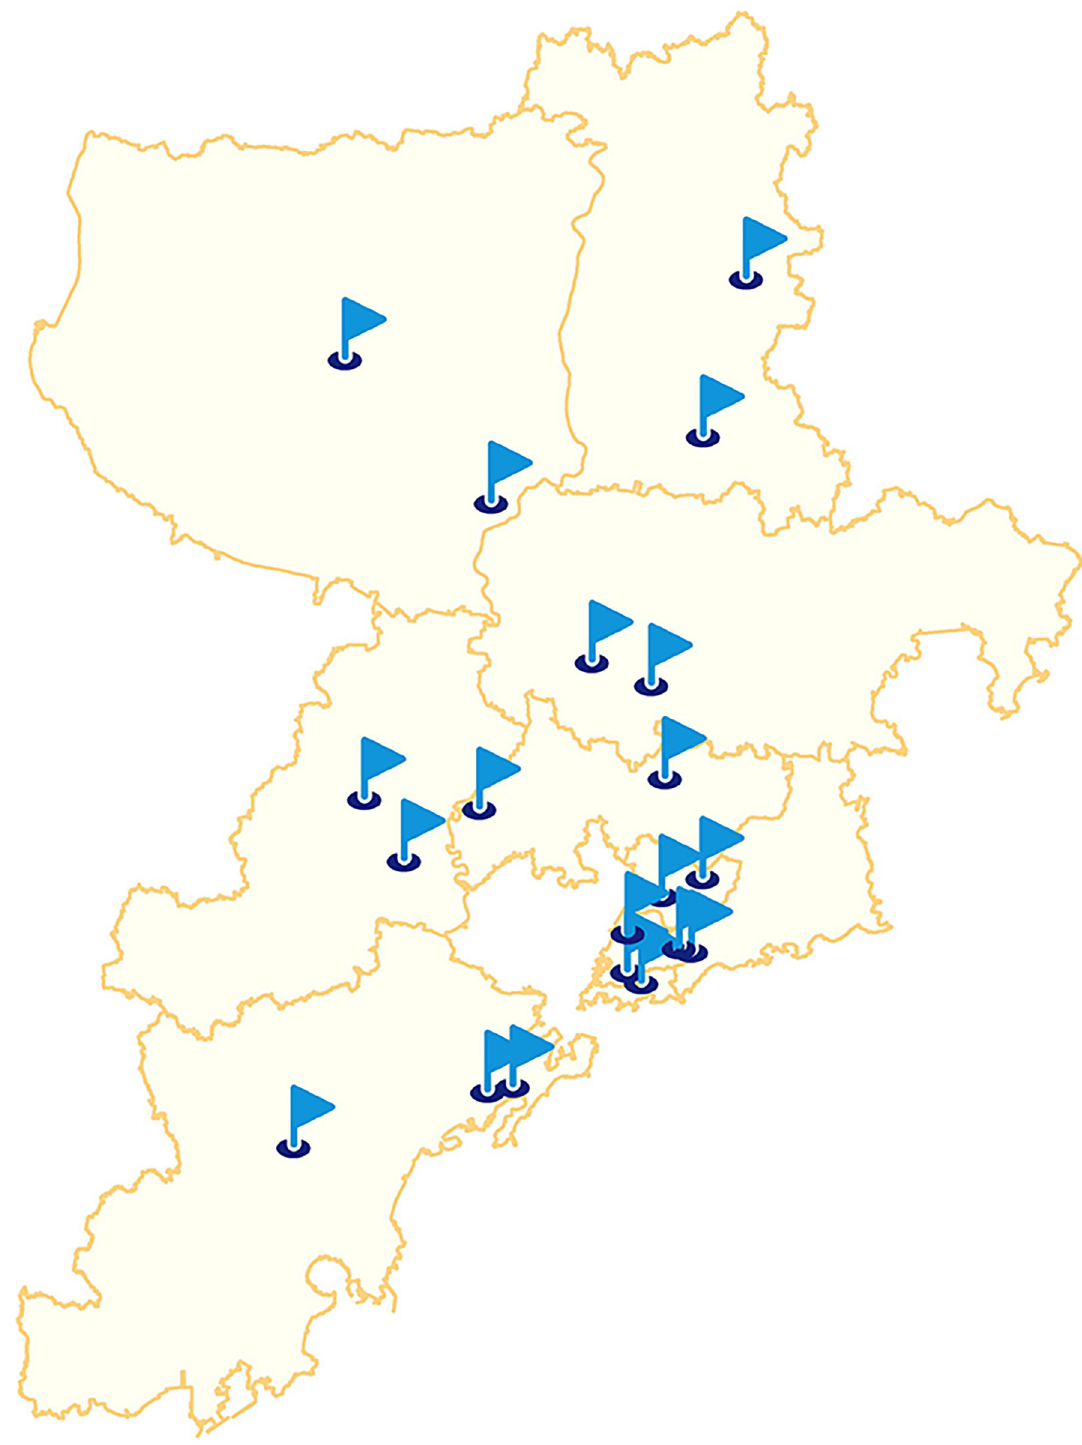
Fig 9. The location distribution map of 20 residential communities selected as a random sample.